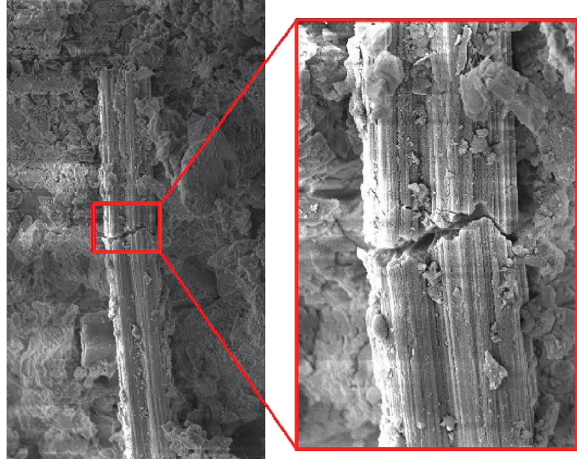
Figure 14: SEM images of fiber